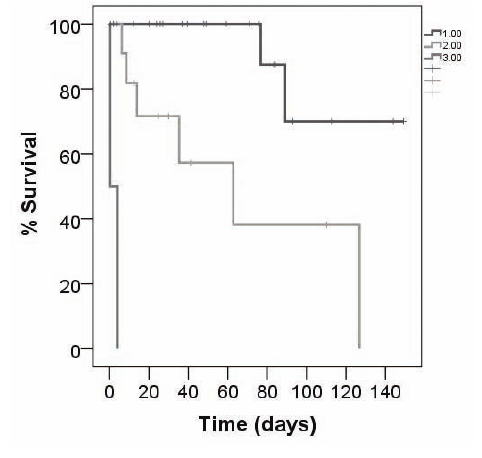
Figure. F64 - SENSITIVITIES AND SPECIFICITIES FOR LITE)